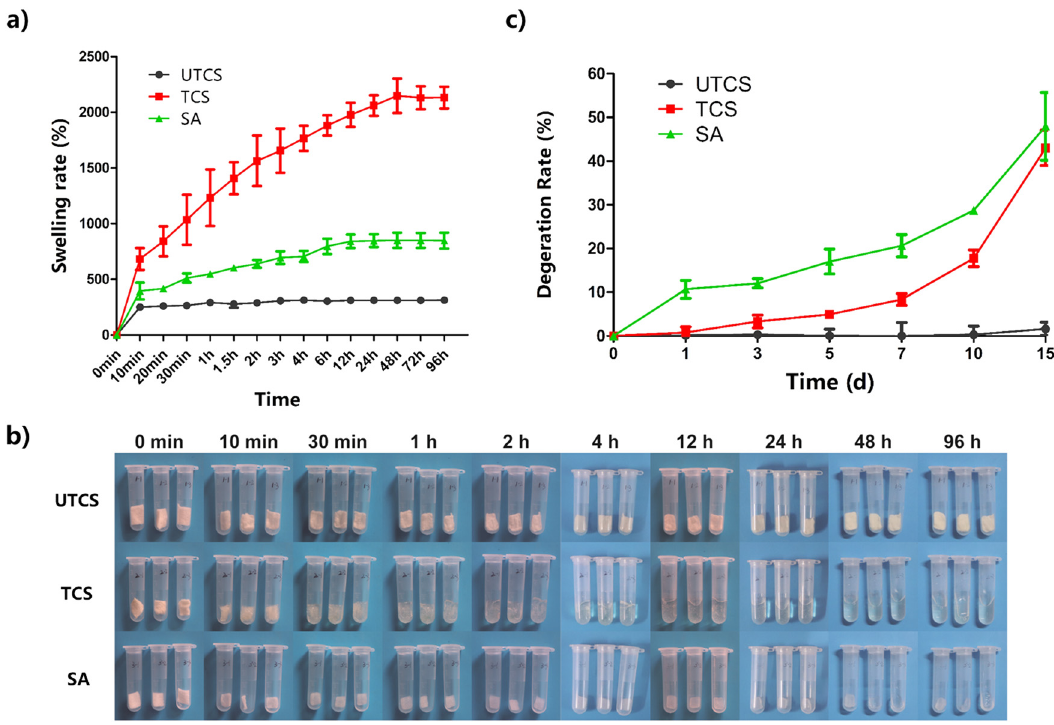
Figure 5: ( a ) Swelling curves of three di ff erent dressings; ( b ) swelling behavior of three dressings in PBS; ( c ) degradation of three dressings within 15 days. Each group had three parallel samples ( n = 3 ) . All data were mean ±